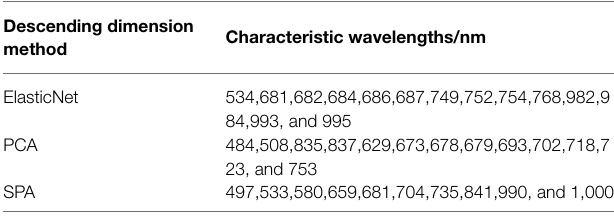
TABLE 5 | Spectral characteristic wavelengths for ElasticNet, PCA, and SPA screening. Descending dimension method